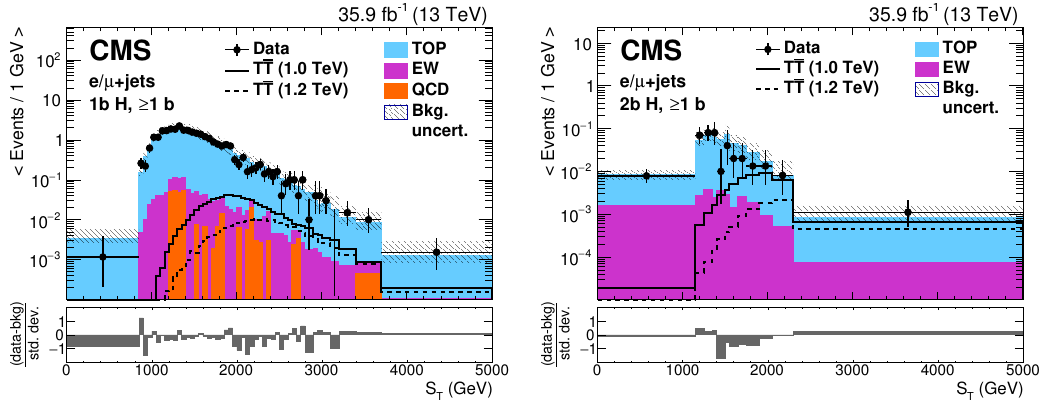
Figure 6 . Distributions of S T before the (cid:12)t to data in the single-lepton H1b (left) or H2b (right) categories. Uncertainties, indicated by the hatched area, include both statistical and systematic components. The black points are the data (horizontal bars indicate the bin width) and the (cid:12)lled histograms show the simulated background distributions, grouped into categories as described in section 3. The (cid:12)nal bin includes over(cid:13)ow events. The expected signal is shown by solid and dotted lines for T quark masses of 1.0 and 1.2 TeV. The lower panel shows the di(cid:11)erence between data and background divided by the total uncertainty.